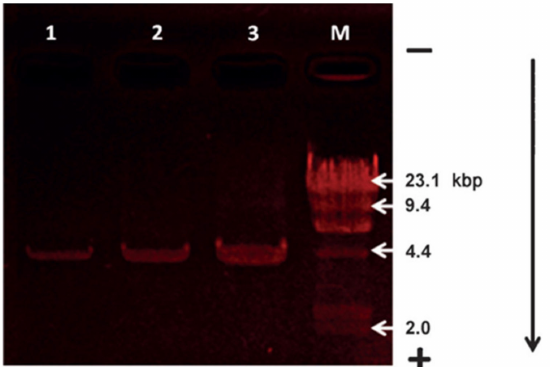
Figure 33. Image of agarose gel electrophoresis assays of plasmid DNA (4.1 kbp). Lanes 1, 2, and 3 were loaded with 64 mg, 128 mg, and 320 mg of DNA, respectively. Lane M: DNA molecular-weight marker. The gel was poststained by probe 11 (50 µ M) for 60 min. The arrow indicates the direction of DNA migration